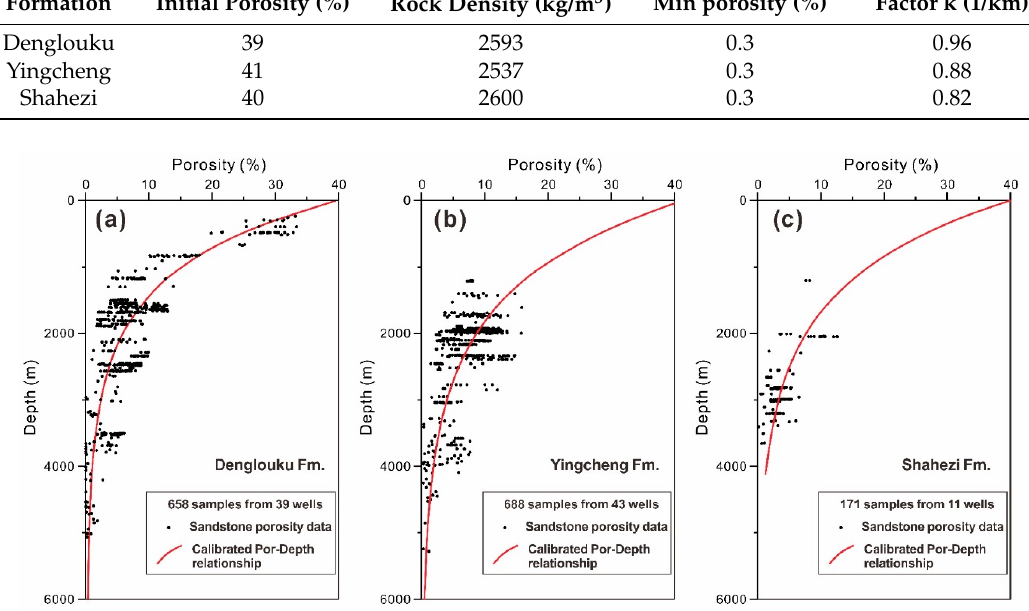
Figure 9. Porosity versus depth curve (red curve) as calibrated by measured data (black dots). ( a ) Porosity calibration curve of K 1 d. ( b ) Calibration curve of K 1 y. ( c ) Calibration curve of K 1 sh.